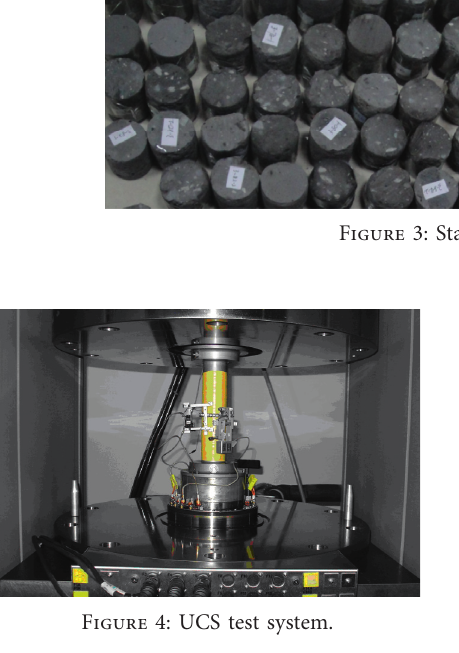
Figure 5: Tensile strength test system.